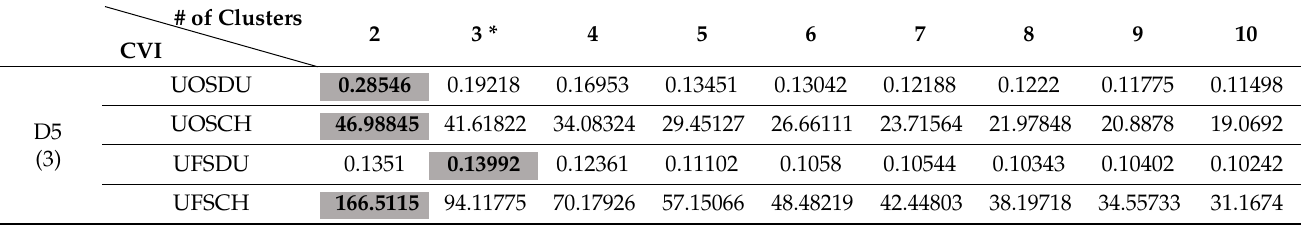
Table 6. Performance results for D5.